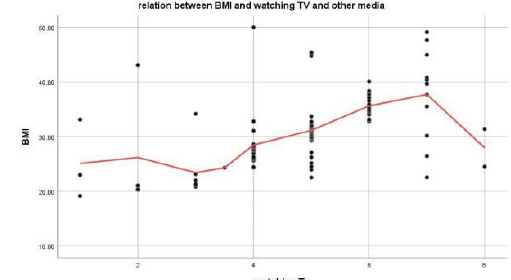
Fig. 5. The linear significant association between BMI and hours of watching TV and other media each day according to the probability value in the correlation test (p=0.000) in table